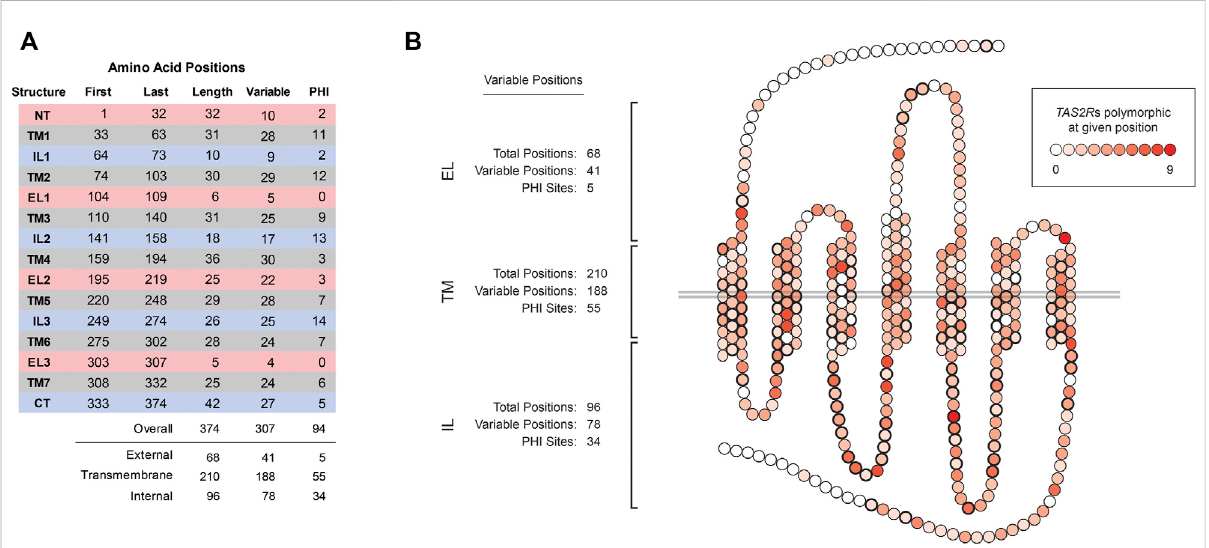
FIGURE 1 Variation across TAS2R substructures. (A) Coordinates, lengths, and numbers of variable and PHI sites in external loops (ELs), transmembrane (TMs),andinternalloops(ILs).N-terminusandC-terminussiteswerecategorizedasELandIL,respectively. (B) Distributionofvariabilityacrossamino acid positions. Shading indicates the number of TAS2Rs variable at the indicated position, which ranged from 0 to 9 of 23 receptors. Positions affected by PHI variants are indicated in